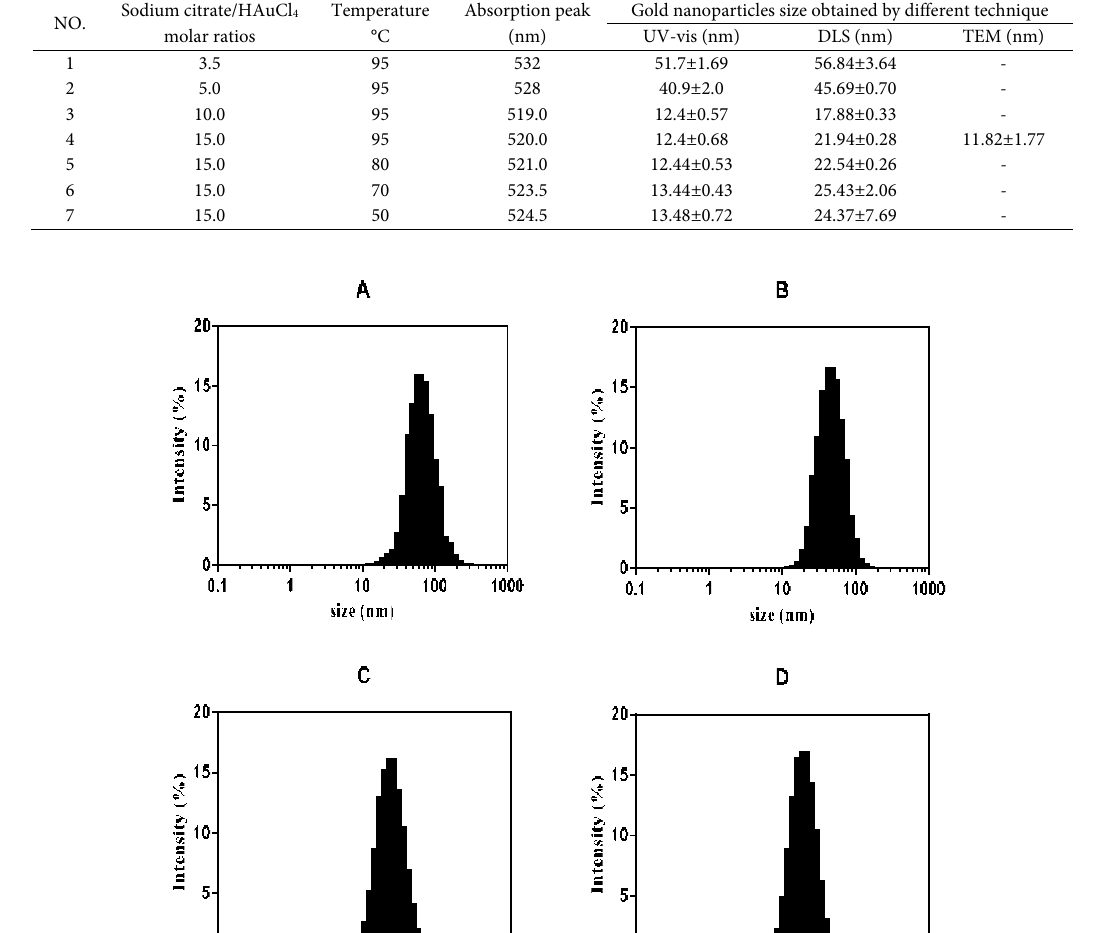
Table1. Summary of data that shows absorption peak of gold nanoparticles which obtained by UV-vis spectroscopy and size of gold nanoparticles samples determined via different characterization techniques: UV-vis spectroscopy (Eq. 1), DLS and TEM. NO.